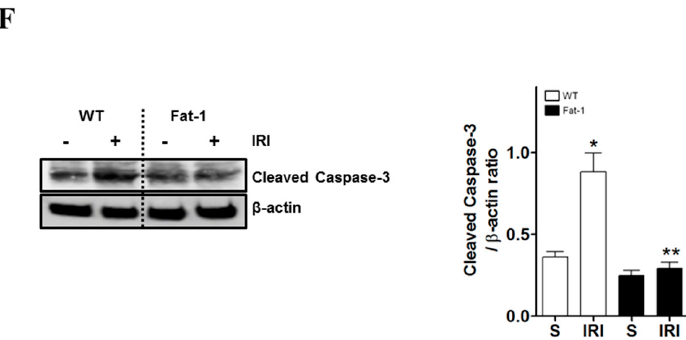
Figure 2. Renal histology and apoptosis in ischemia-reperfusion (IR) kidney (WT-S, wild type sham; WT-IRI, IR renal injury in wild-type mice; fat-1, fat-1 induction sham; fat-1 IRI, IR renal injury in fat-1 induction mice). ( A ) Representative kidney section stained peroxidic acid-schiff (PAS) stain; yellow arrows indicate necrotized tubules or the formation of cast Yellow arrowheads indicate loss of brush border or dilated tubules. Black arrows indicate necrotized tubules and inflammatory cells. Original magnification, 200 × . Scale bar = 200 µ m; ( B ) A semi-quantitative analysis of tubular injury in wild-type and fat-1induction mice kidneys 24 h after IR renal injury ( n = 5/each group); ( C ) Representative kidney section with H&E stain; yellow arrows indicate necrotized tubules. Yellow arrowhead indicate inflammatory cells. Black arrows indicate necrotized tubules and inflammatory cells. Original magnification, 200 × . Scale bar = 200 µ m; ( D ) A semi-quantitative analysis of tubule interstitial injury in wild-type and fat-1 induction mice kidneys 24 h after IR renal injury ( n = 5/each group); ( E ) Representative TUNEL stain of kidney section. Original magnification, 400 × . Quantification of Apoptosis Index. Scale bar = 50 µ m; ( F ) Representative western blot and quantification of densitometry of caspase-3. * p < 0.05 vs. WT-sham kidney, # p < 0.05 vs. fat-1-sham kidney, ** p < 0.05 vs. WT-IR kidney. Bar represents mean ± S.D.